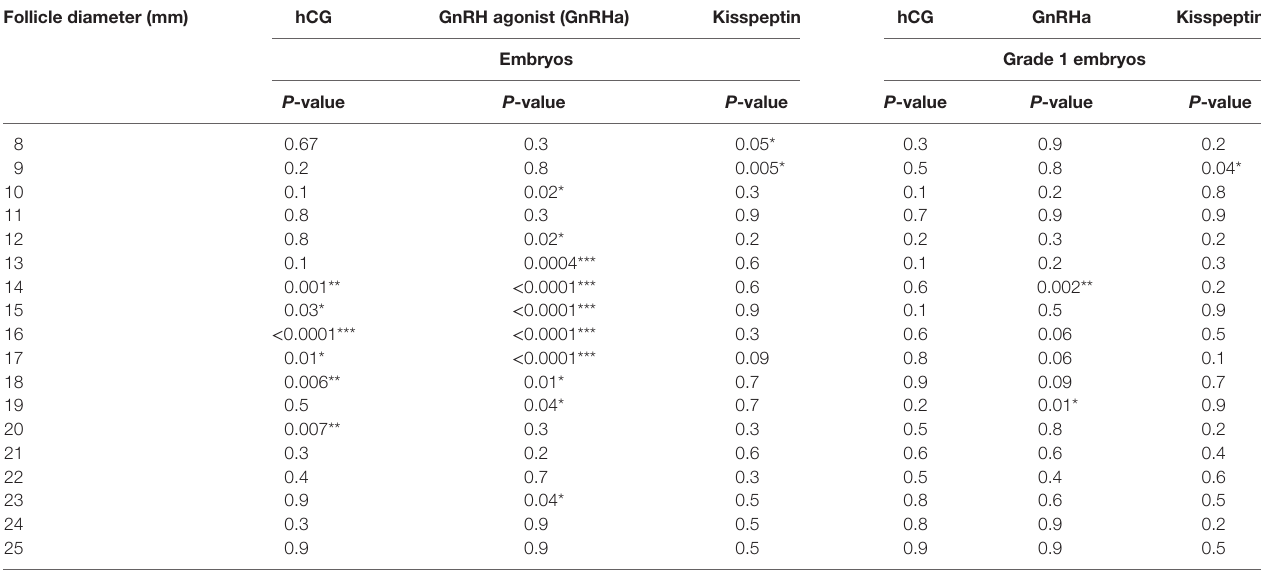
Table 4 | Generalized linear model—number of embryos and number of high grade embryos. Follicle diameter